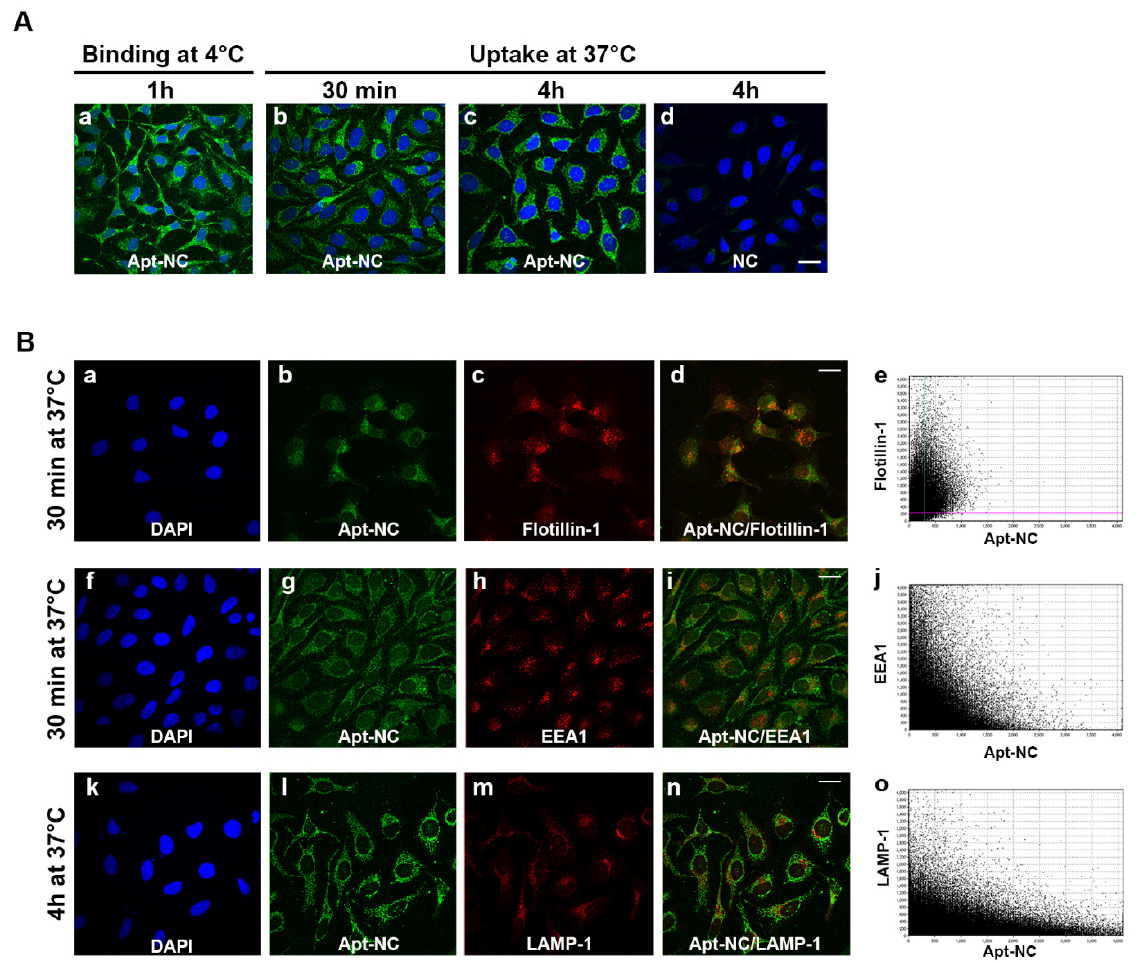
Figure 3. ( A ) Confocal analysis of membrane-binding and intracellular distribution of Apt-NCs. HeLa cells were incubated with 60 nM of biotinylated Apt-NCs (panels a – c ) or non-functionalized NCs (panel d ) for 1 h at 4 °C (panel a ) or for 30 min and 4 h at 37 °C (panels b – d ), as indicated. ( B ) Co-localization analysis of Apt-NCs (panels b , g , l ) with flotillin-1 (panel c ), endosomal marker EEA1 (panel h ), and lysosomal marker LAMP-1 (panel m ). The ( b , c ) images are merged in (panel d , g , h ) images are merged in (panel i ), and the ( l ) and m images are merged in (panel n ). Cell nuclei are visualized in (panels a , f , k ). The correlation of the intensity values of the green and red pixels was performed using the IMARIS software and scatter plots are reported in (panels e , j , o ). Biotinylated NCs were visualized using streptavidin–FITC and nuclei were stained with DAPI. Scale bar: 20 μ m.